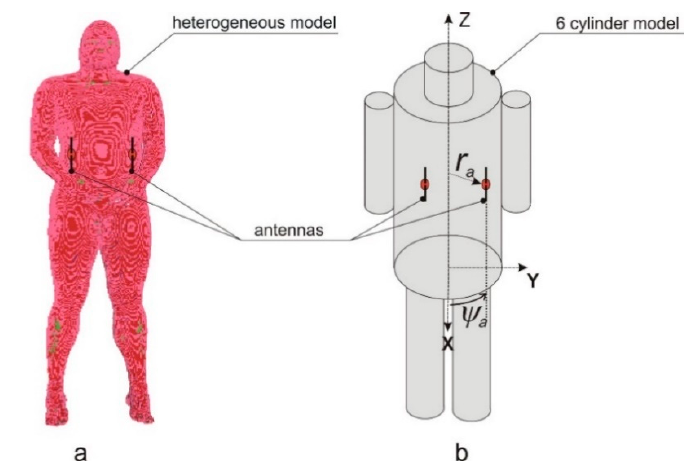
Figure 2. Antenna array on a human body model: ( a ) heterogeneous anthropomorphic model; ( b ) cylindrical model of the human body: r a , ψ a —coordinates of a single antenna.